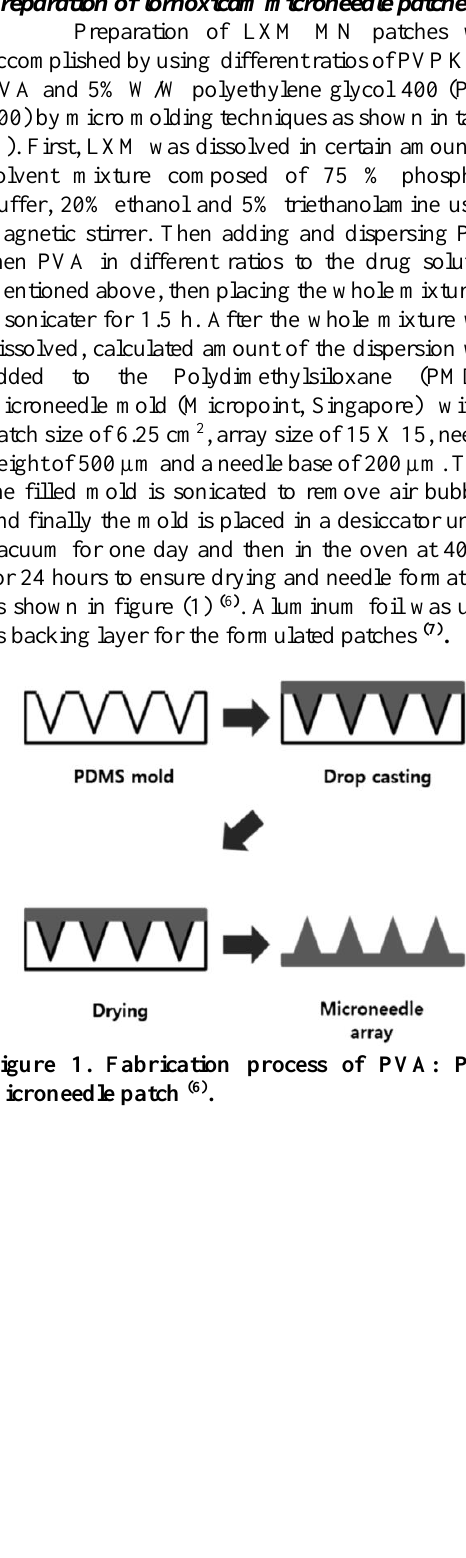
Table 1. Composition of prepared micro needle patches using different ratios of PVA and